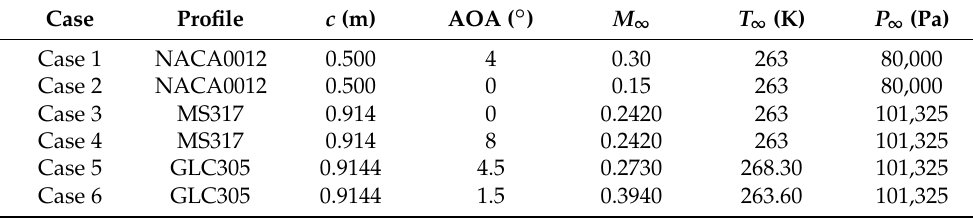
Table A1. Test cases for the analysis of the boundary-layer